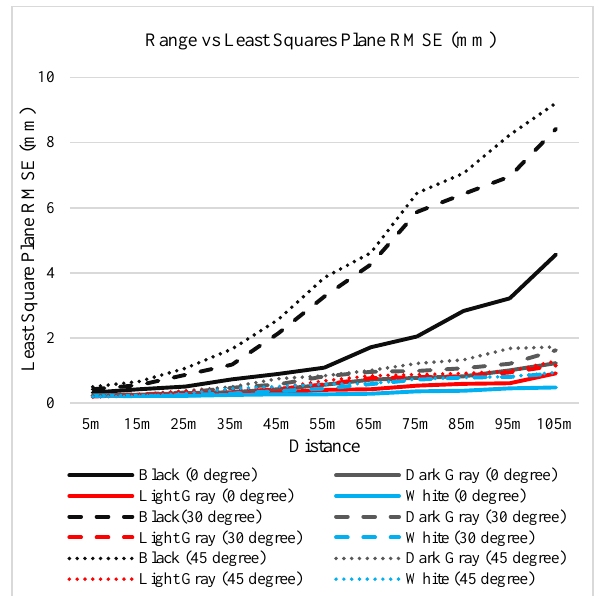
Figure 5. Variation of Least Square Plane RMSE depending on intensity, range and incidence angle